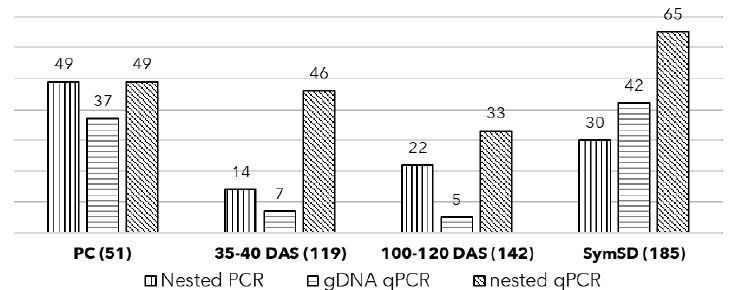
Figure 5. Phytoplasma positivity rate observed among three screening methods used; end-point nested PCR, qPCR using gDNA as a template, and nested qPCR using PCR product of P1/P7 as a template. Positivity rate observed in positive control samples (PC), seedlings collected at 35–40 DAS, seedlings collected at 100–120 DAS, and seeds collected from SSD symptomatic sandalwood trees (SymSD). The figures in the parenthesis indicate the number of samples screened for phytoplasma, and the figures on the top of the bar indicate the number of samples that tested positive for phytoplasma.